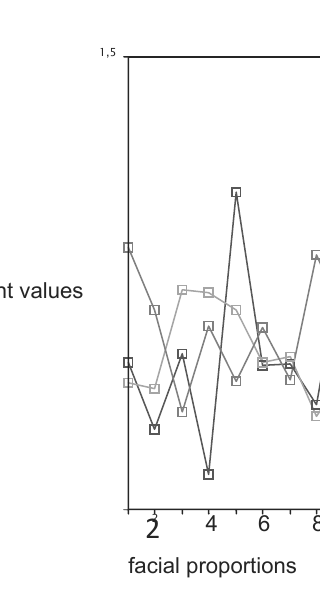
Fig. 4. Relation between facial metric parameters and desirable to have sex with – not desirable to have sex with.